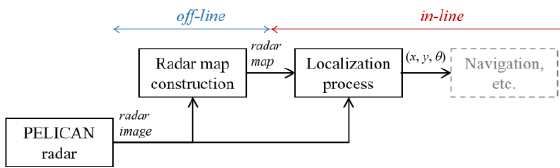
Figure 1. General description of map construction and